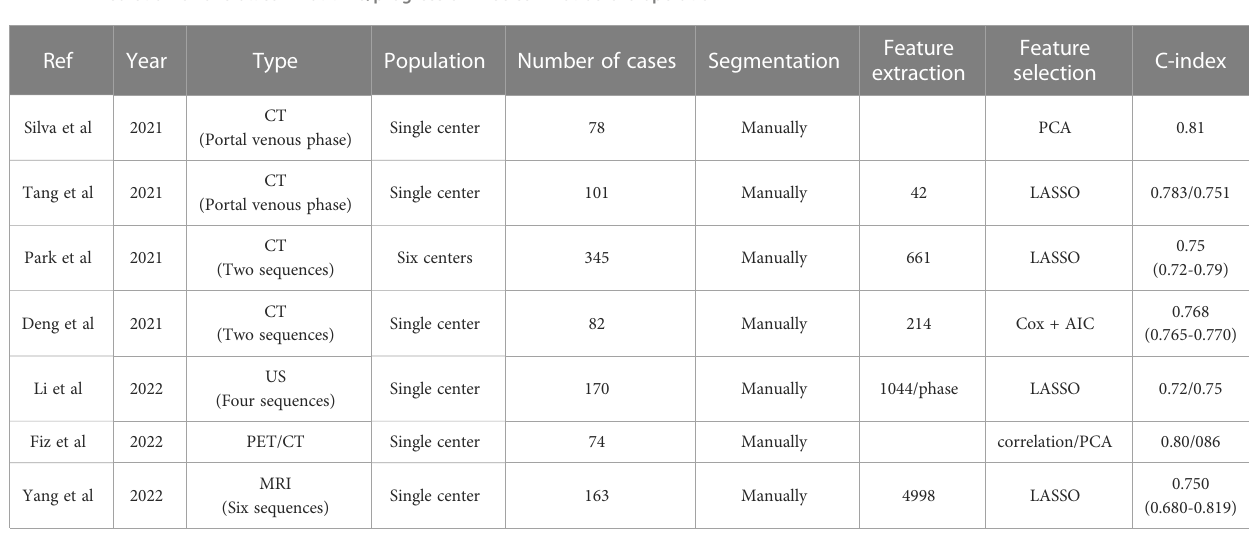
TABLE 2 Prediction of overall survival time/progression-free survival before